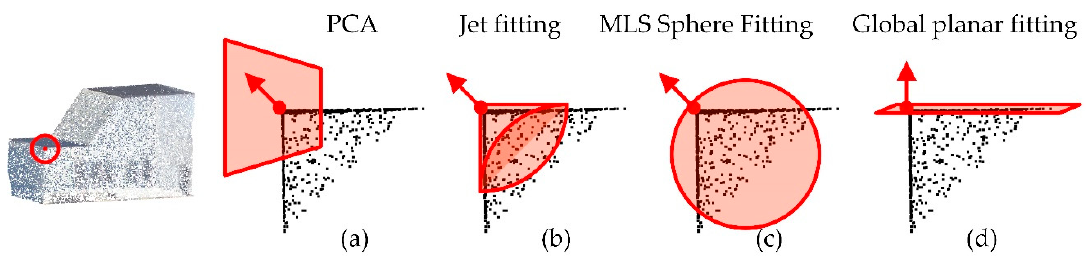
Figure 1. Different region selection and geometric kernel for normal estimation. Principal component analysis (PCA) ( a ), jet fitting ( b ) and MLS Sphere fitting ( c ) generally use local regions, and select planes, quadratic surfaces, and spheres as the geometric kernel, respectively. In addition, the geometric kernel can also be learned from exemplar datasets ( d ). However, for noisy photogrammetric point clouds in urban environments, a large context should be selected to keep sharp features, such as the sharp edges of a building.